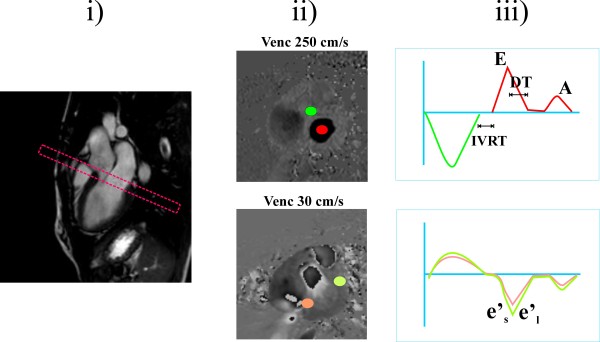
Illustration of the prescription and measurements obtained from phase contrast MR. Two identical stacks of phase contrast images were prescribed on a 3 chamber view of the heart (i). To assess transmitral and aortic flow, a velocity encoding (venc) of 250 cm/s was used and the center of the slice was positioned perpendicular to mitral inflow, at early diastole (ii, upper panel). To assess tissue MR velocities, phase-contrast MR was repeated with a velocity encoding of 30 cm/s, (ii, lower panel) To derive aortic and trans-mitral flow (iii, top panel), circular regions of interest were placed in the aortic (green) and mitral valve (red). On the corresponding mitral flow curve (panel iii, red) the peak mitral velocity of rapid early (E) filling wave late atrial (A) filling wave were recorded. The deceleration time (DT) of the early (E) wave of the mitral valve was computed between the peak of the E wave and the point where the fitted line of descending slope of the E wave reached zero velocity. The isovolumic relaxation time (IVRT) was computed as the delay between the end of the aortic valve flow and the beginning of the transmitral flow. On the tissue velocity images (ii lower panel, regions of interest were placed on the septal (orange) and lateral wall (yellow) and corresponding tissue velocity versus time curves were plotted (iii lower panel). From these curves, peak tissue velocity in early diastole in the septum (e's) and lateral wall (e'l) was measured and average E/e'ratio was computed.